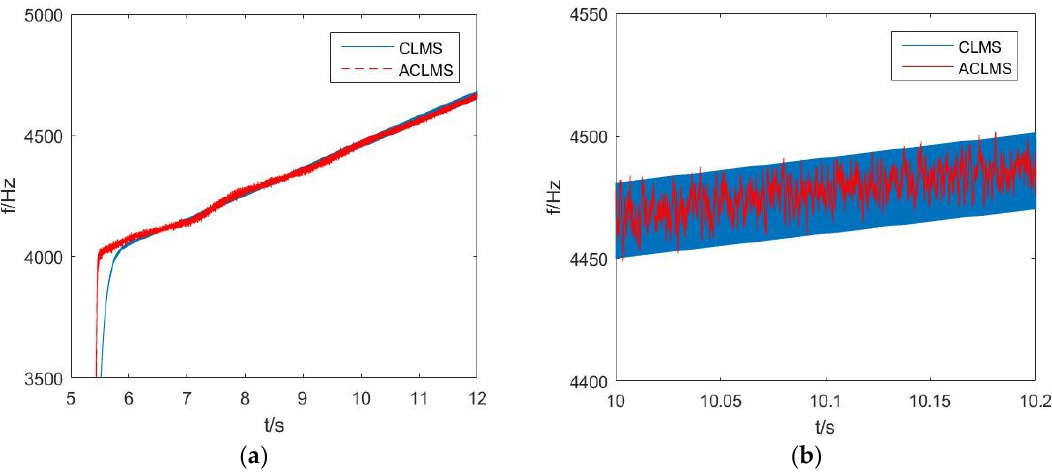
Figure 11. Frequency estimation for a real vector hydrophone system: ( a ) the MATLAB processing result; ( b ) Selected enlarged part of ( a ).